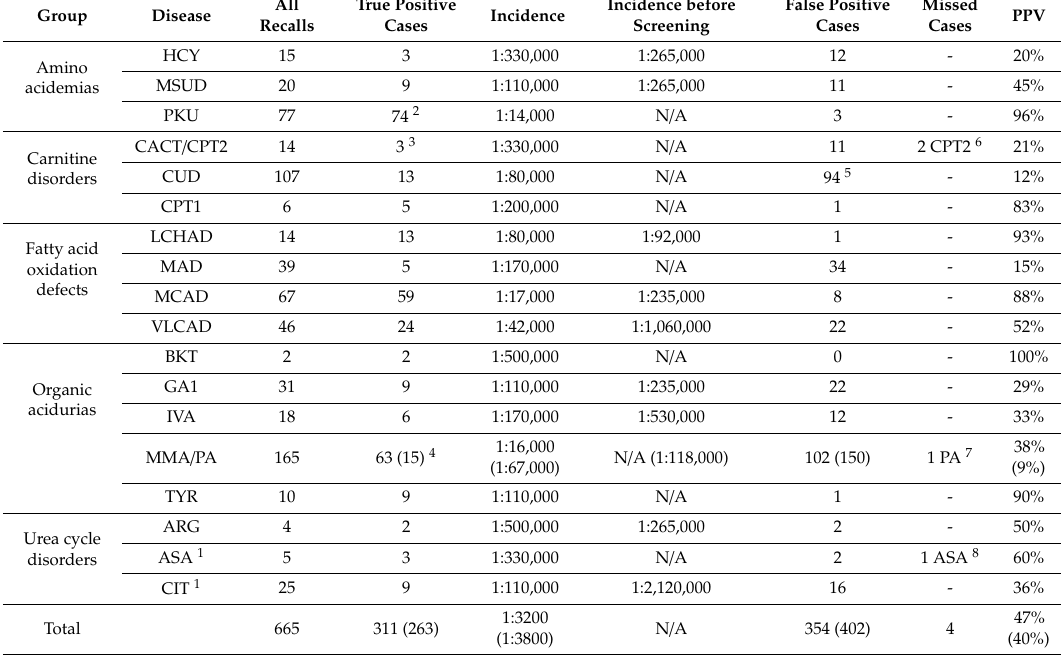
Table 1. All recalls, true positive cases, incidences during and before screening, false positive cases, missed cases, and PPV values during the entire reporting period. Within parenthesis are listed the corresponding numbers if counting babies with confirmed vitamin B12 deficiency as false positive. N / A stands for not